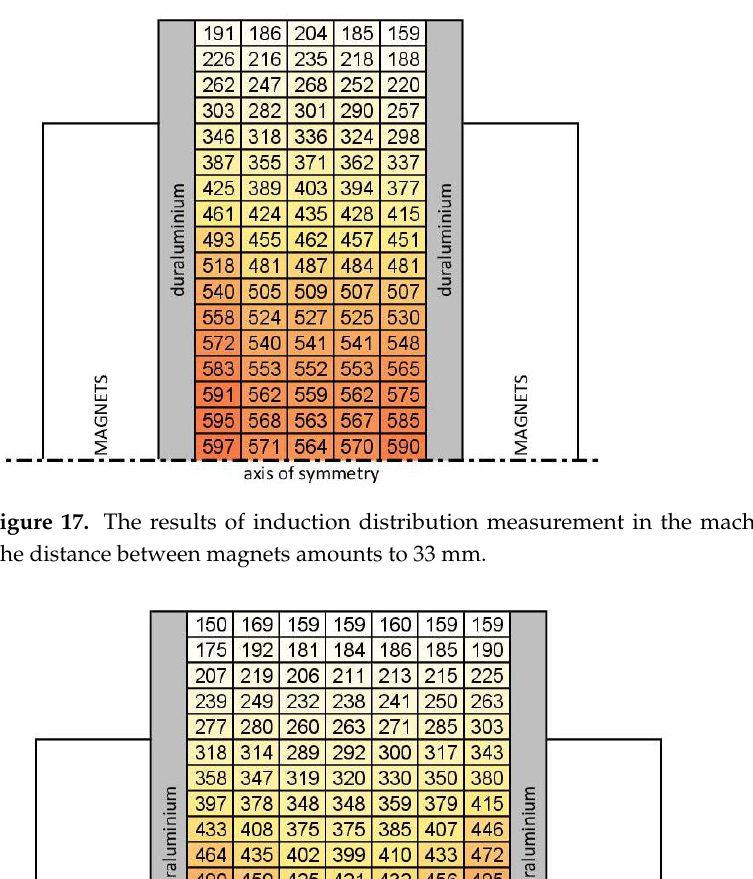
distance between magnets amounts to 28 mm.